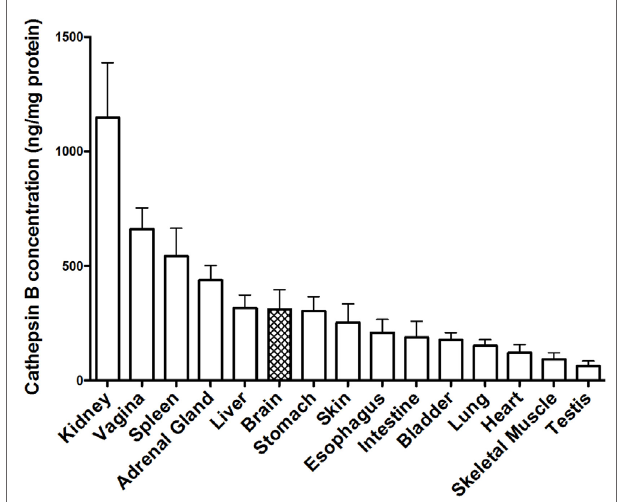
FiGURe 5 | Cathepsin B protein concentration vary among tissues . The levels of mature cathepsin B concentrations are shown from rat tissues (mean ± SD displayed, N = 4 analyses, means significantly different, ANOVA, p < 0.0001) (165). Data from the cited publication and adapted to graphic display and analyzed for variance.